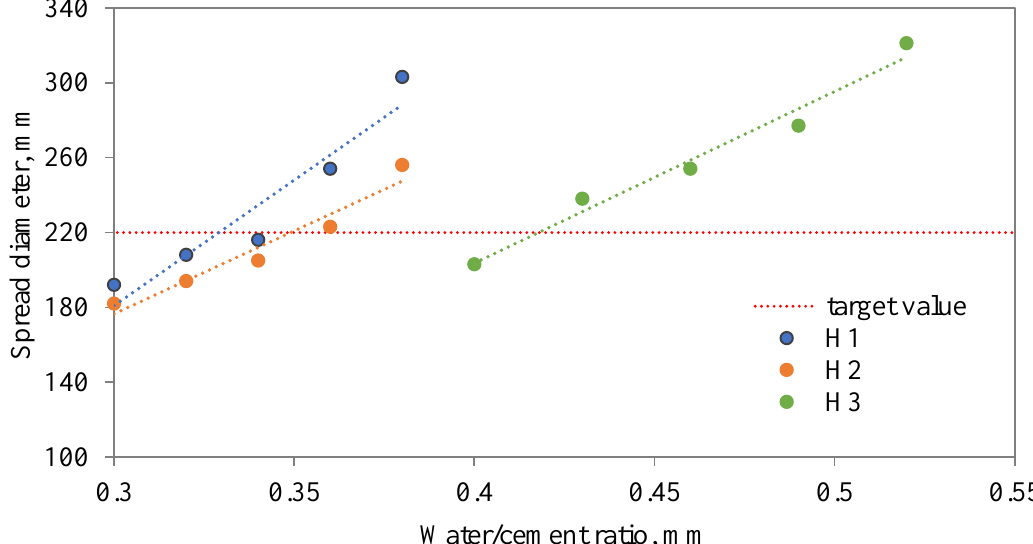
Figure 5. Dependency between spread diameter and additional water dosage for C mixtures.